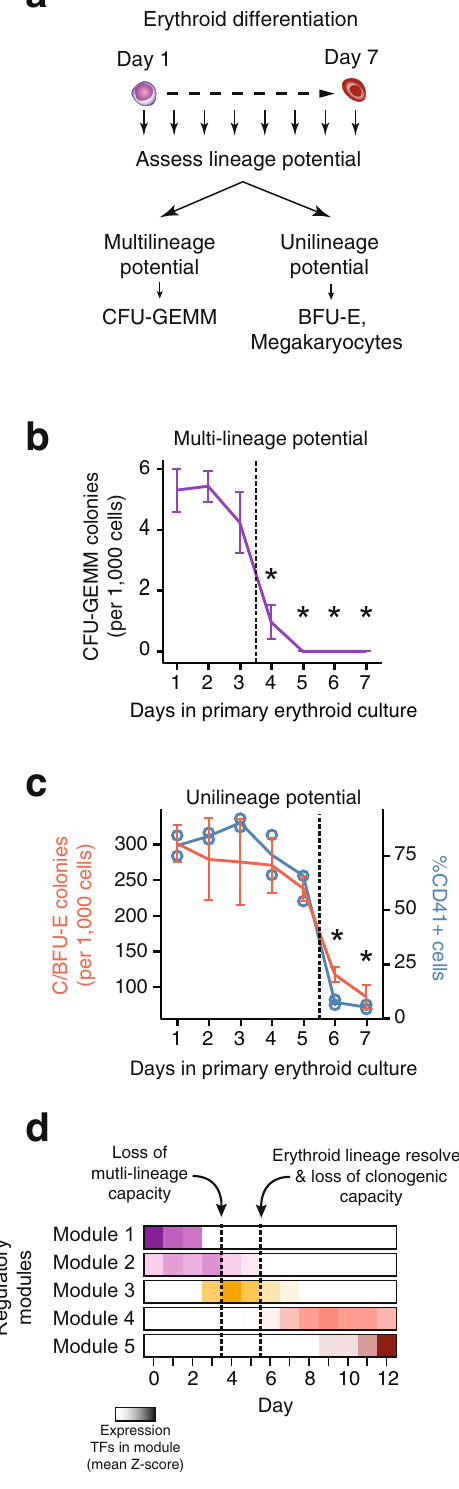
Fig. 4 Lineage restriction events during erythropoiesis re fl ect the sequence of regulatory programs. a Schematic diagram of lineage potential assays during the fi rst 7 days of ex vivo erythropoiesis. Cells were sampled daily and transferred to lineage-permissive media. Multilineage capacity was determined as frequency of CFU-GEMM progenitors. Erythroid potential as frequency of BFU-Es and megakaryocytic potential as frequency of CD41 + cells. b Frequency of multipotent CFU-GEMM in methylcellulose assay from cells sampled over the course of erythroid differentiation. c Frequency of unipotent erythroid progenitor colonies (BFU-E) in methylcellulose assay (red line) and frequency of CD41 + cells after transplantation in secondary megakaryocytic media (blue line).